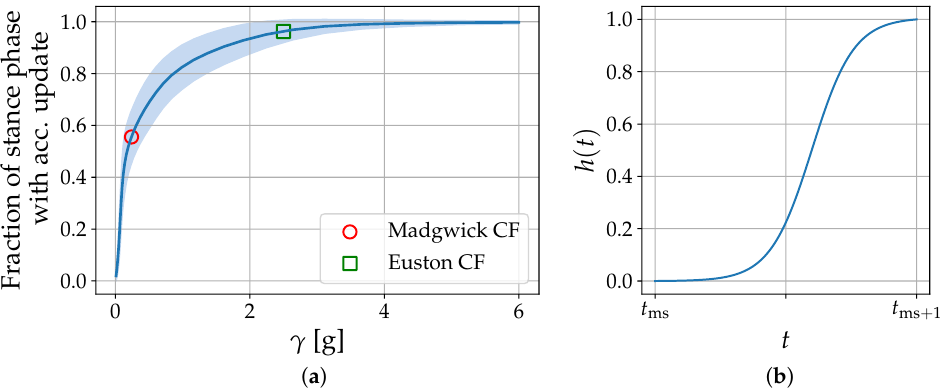
Figure 5. ( a ) Average fraction of the stance phase with an accelerometer orientation update for a given value of γ on the complete dataset. One standard deviation around the mean is shown in light color; ( b ) Optimal weighting function h ( t ) in the direct and reverse integration scheme for t 0 = 0.6 and η =